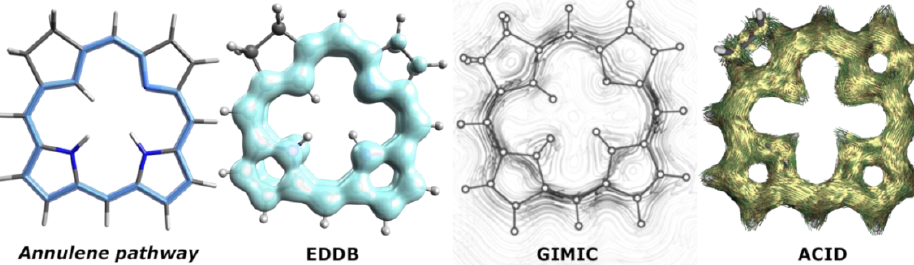
Figure 8. EDDB, GIMIC, and ACID visualization of electron delocalization pathway in porphyrin, compared to the [18]annulene pathway proposed by Vogel to explain aromaticity in porhyrins. Source: [103].